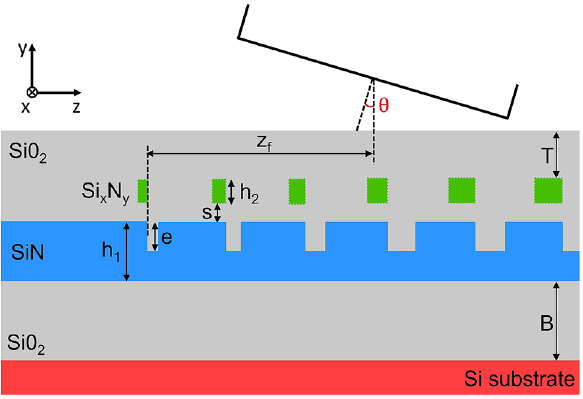
Figure 6. 2D schematic view of the proposed dual-level Si x N y –Si 3 N 4 GC.